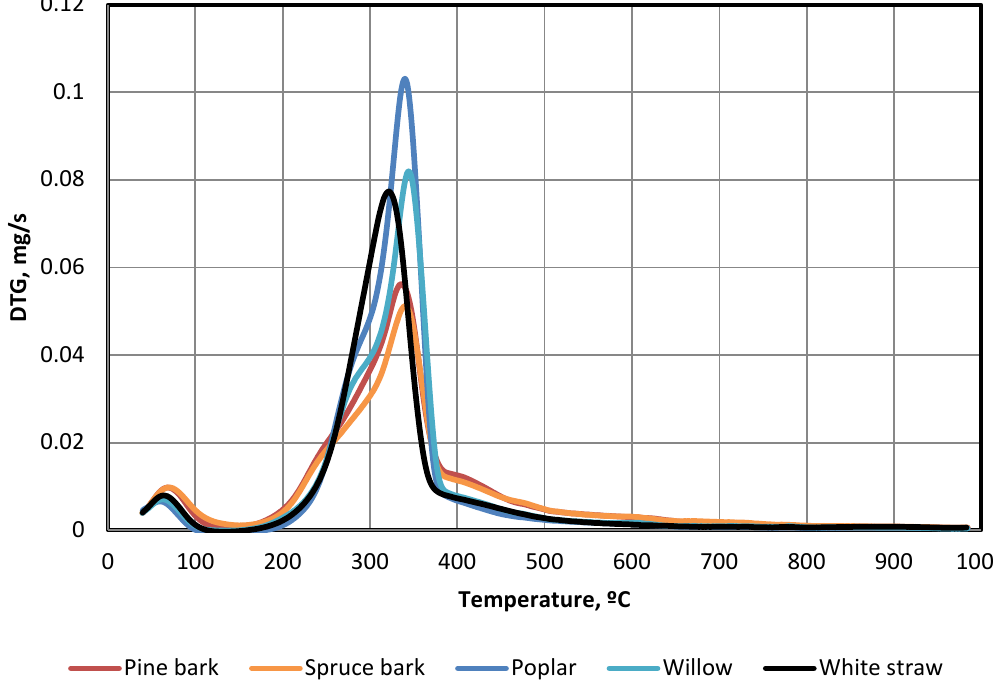
Figure 2. DTG curves comparison.